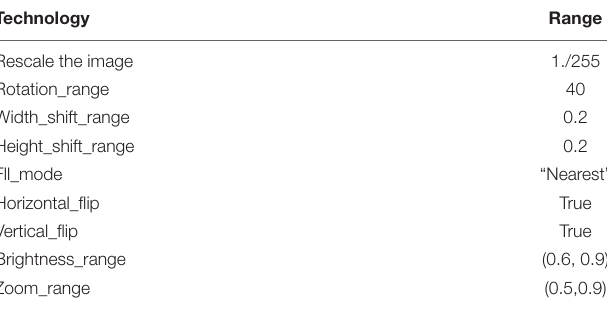
TABLE 1 | Parameter set for data augmentation.